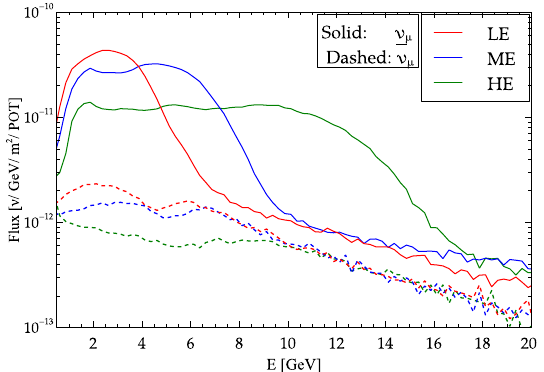
Figure 22.1: Comparison of the different flux tunes (LE, ME, HE) in the neutrino running mode. POT stands for protons on target. Taken from [ 377 ]